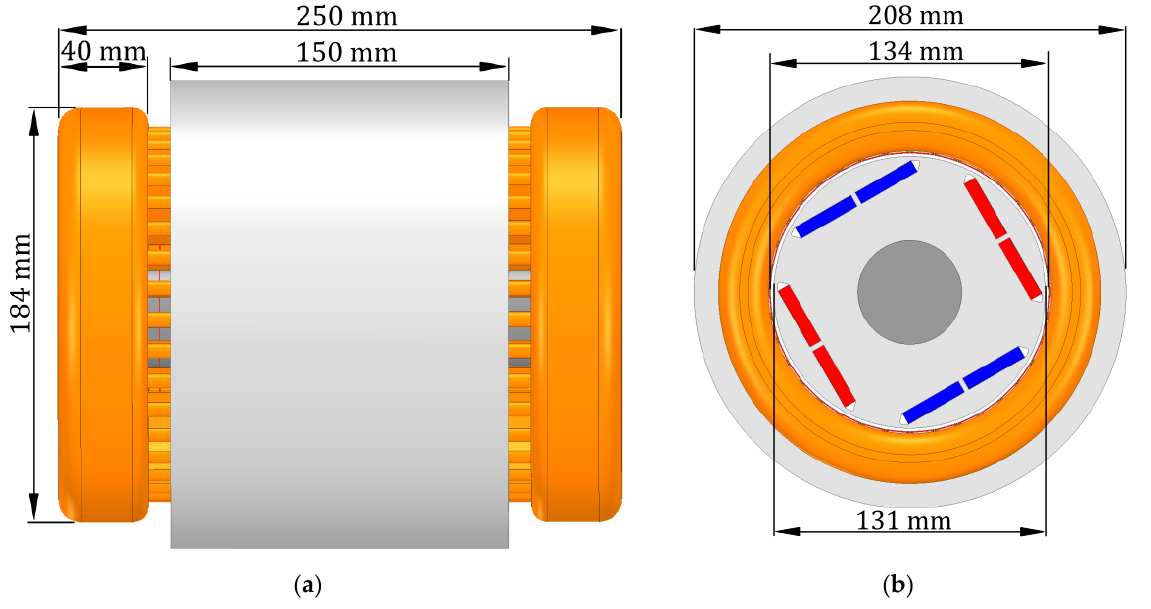
Figure 8. Reference model of a PMSM machine with an IPM rotor, with the most important geometrical dimensions marked: ( a ) side view, ( b ) front view.